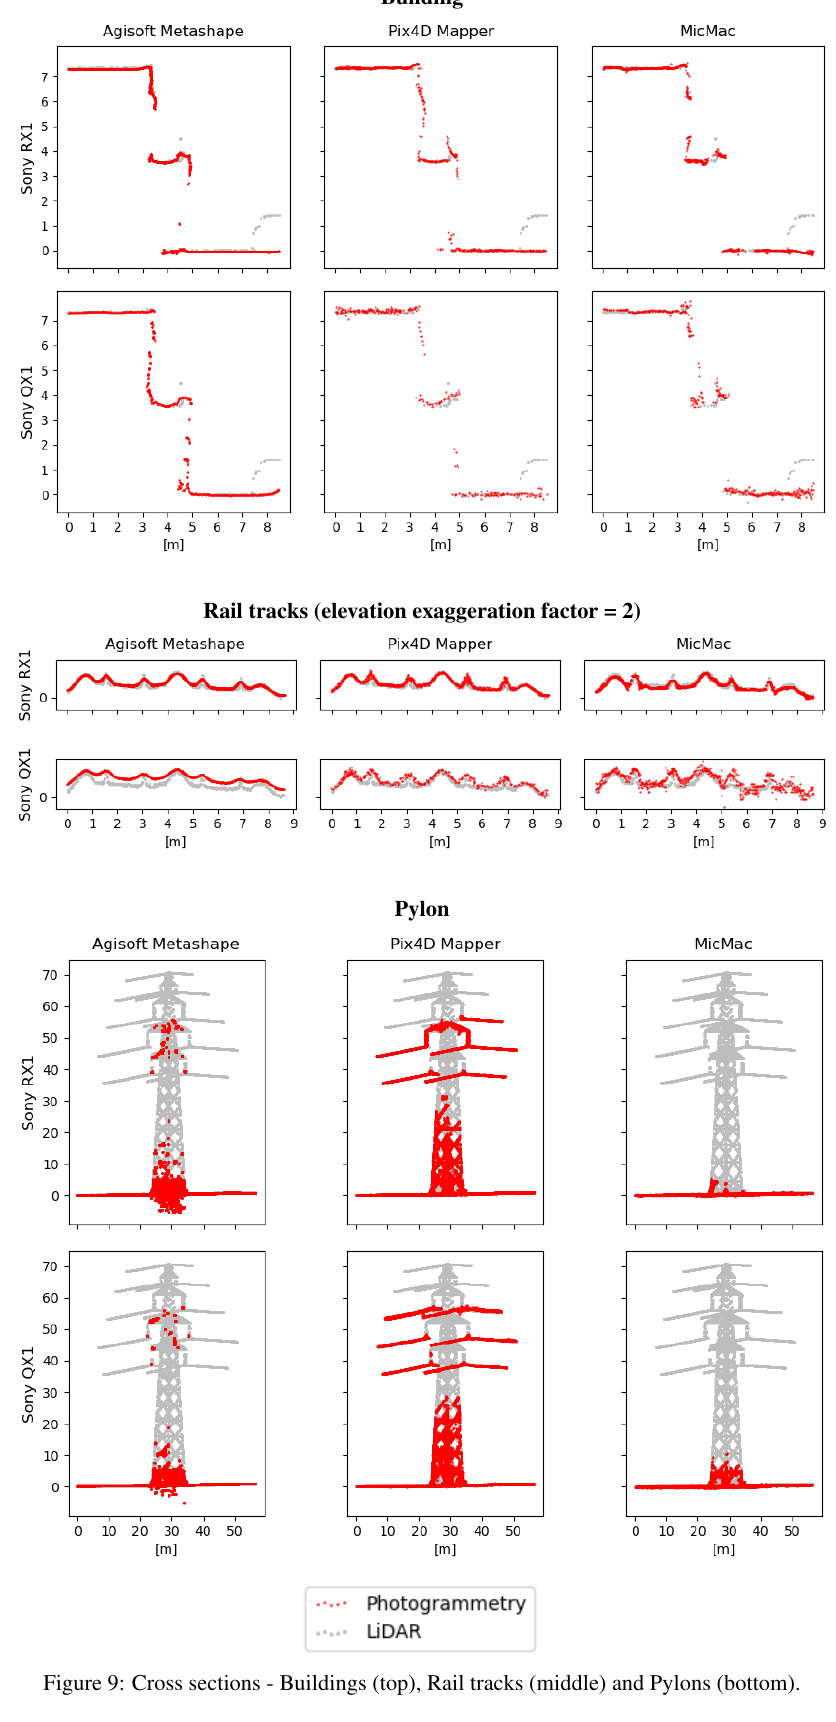
Figure 9: Cross sections - Buildings (top), Rail tracks (middle) and Pylons